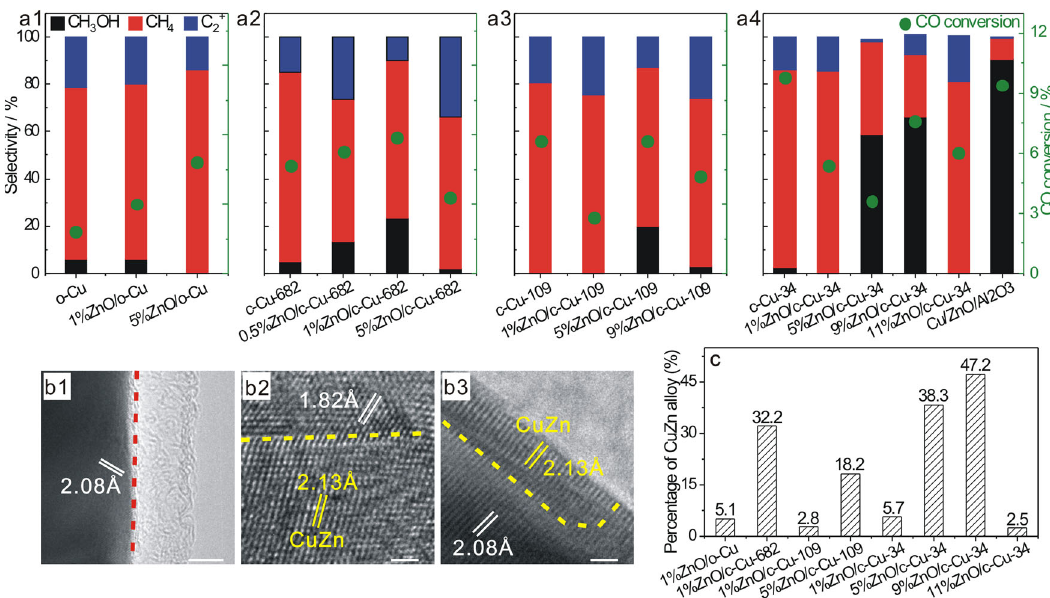
Fig. 6 Catalytic performance in CO hydrogenation reaction and microscopic characterizations. The scale bar of b1 corresponds to 5nm and those of b2 and b3 correspond to 1nm. a1 – a4 Catalytic performance of various Cu and ZnO/Cu catalysts in the CO hydrogenation to methanol reaction. CO 2 is not included for selectivity calculations. Representative HRTEM images of used b1 1%ZnO/d-Cu, b2 1%ZnO/c-Cu-682, and b3 1%ZnO/o-Cu catalysts; c Statistical percentage of CuZn alloy nanoparticles of various ZnO/Cu catalysts derived from corresponding HRTEM images. Lattice fringes of 1.82, 2.08, and 2.13Å respectively correspond to the spacing of Cu{100}, Cu{111} (JCPDS card NO. 89-2838), and ZnCu alloy {111} (JCPDS card NO 89-1397) crystal